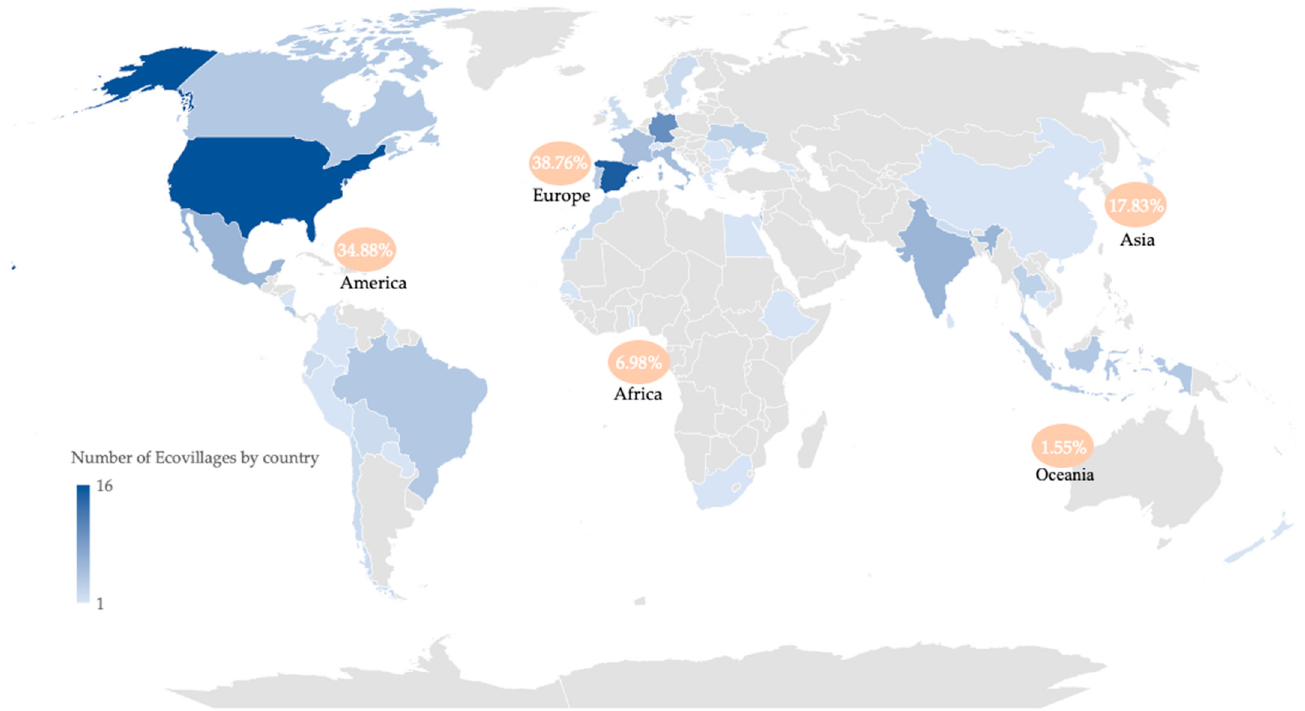
Figure 1. Map of established or aspiring spiritual ecovillages listed in GEN in January.